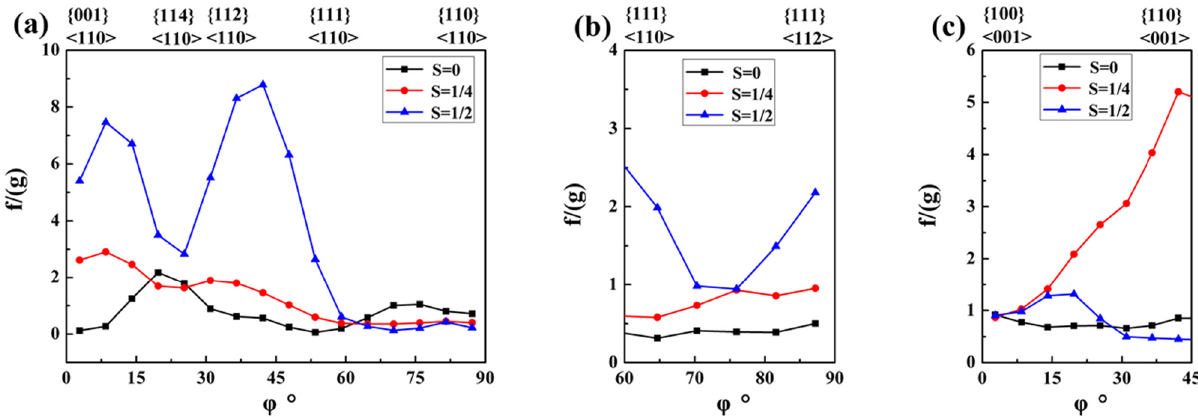
Figure 13: Distribution of orientation lines on di ff erent thicknesses of Y - free hot - rolled sheet: ( a ) α orientation line; ( b ) γ orientation line; and ( c ) η orientation line.